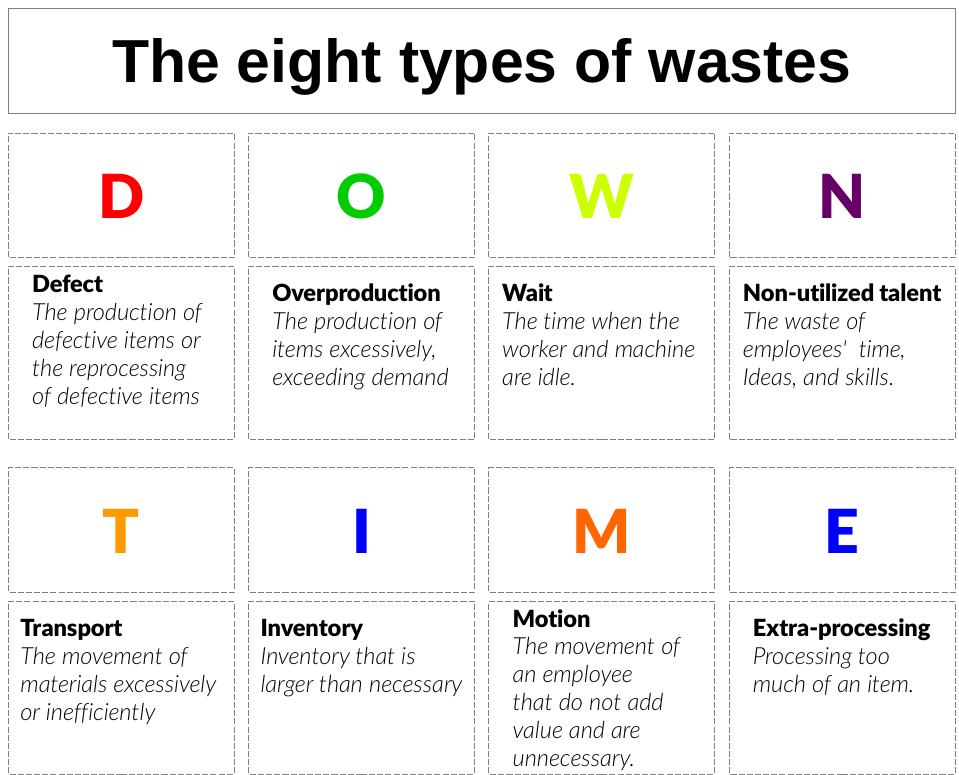
Figure 1. The eight types of